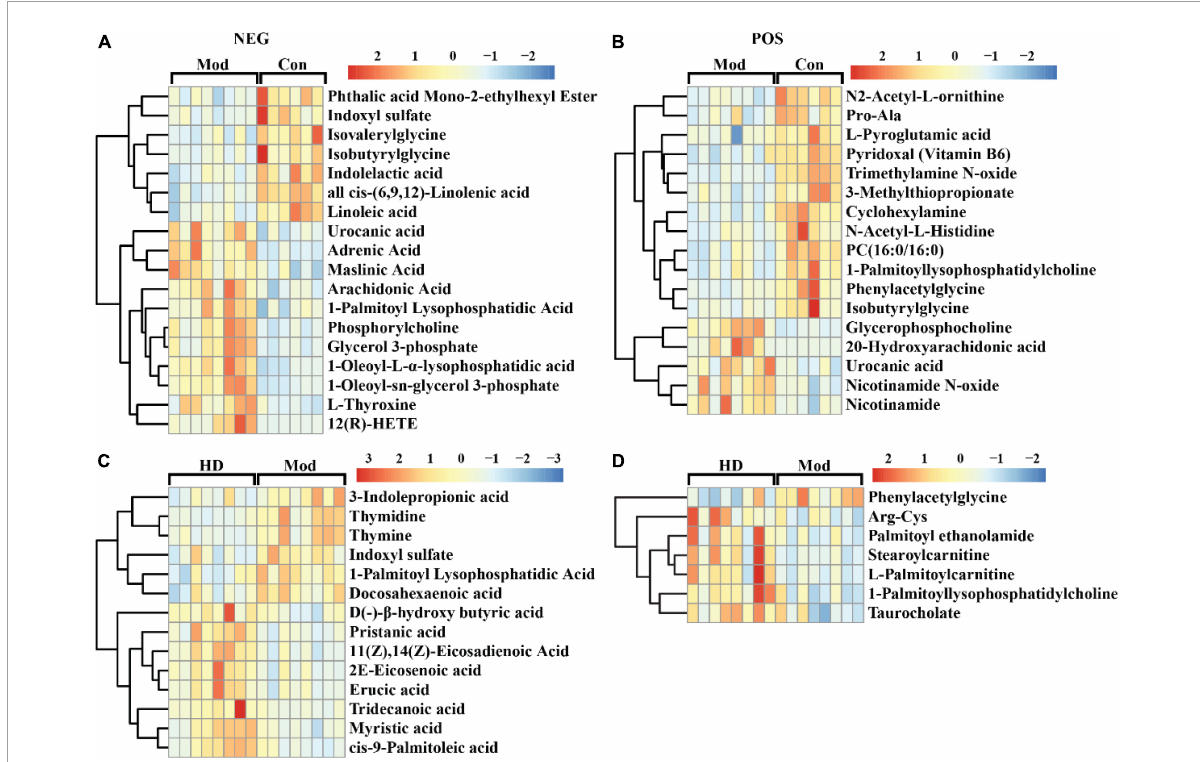
FIGURE4 Heat map of the hierarchical clustering analysis of differential metabolites determined in ESI- mode (NEG) and ESI + mode (POS). (A) Mod vs. Con (NEG), (B) Mod vs. Con (POS), (C) HD vs. Mod (NEG), (D) HD vs. Mod